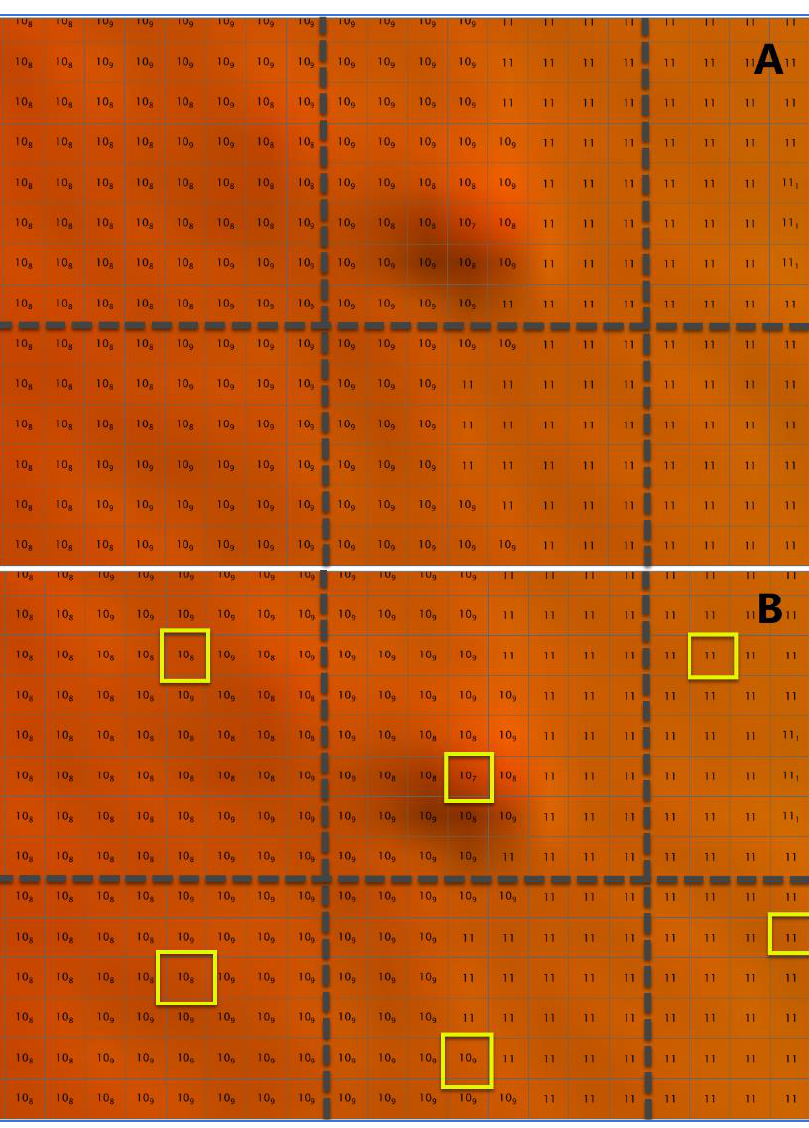
13 Figure 15. Chart Adequacy output using different testing methods. Chart soundings are shown in black and the survey soundings in blue. Both soundings are in meters; when shown, the sub-index represents decimeters. ( A ) shows the output from the Shoalest Depth method, only showing shoal soundings on the deep side of the contours. Thus, this method is useful in the identification of dan- gers to navigation. ( B ) shows the results using the Tilted Triangle method. There are more flagged soundings, in this case depicting the overall shoaling trend. Thus, this method is useful in change detection and assessing chart adequacy. To summarize, the Chart Adequacy tool implements a method of sounding compari- son that has two distinct applications: hydrographic survey review (as a quick identifica- tion of dangers to navigation) and chart review (as a method of validating a prospective chart sounding selection prior to its application). The Sounding Selection tool creates a sounding selection from a bathymetric grid. Once created, the sounding selection can also be used to compare the survey data to the chart using the described Chart Adequacy tool. In fact, the initial motivation to create such a tool was to provide a mechanism to evaluate chart adequacy directly from a bathymetric grid. Two sounding selection algorithms are currently available: Moving Window and Point Additive . The Moving Windows algorithm is quite simple: the bathymetric grid is divided